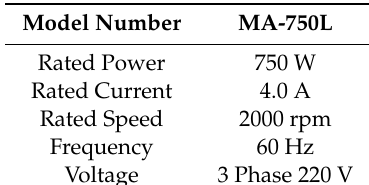
Table 1. Specification of test PMSM.